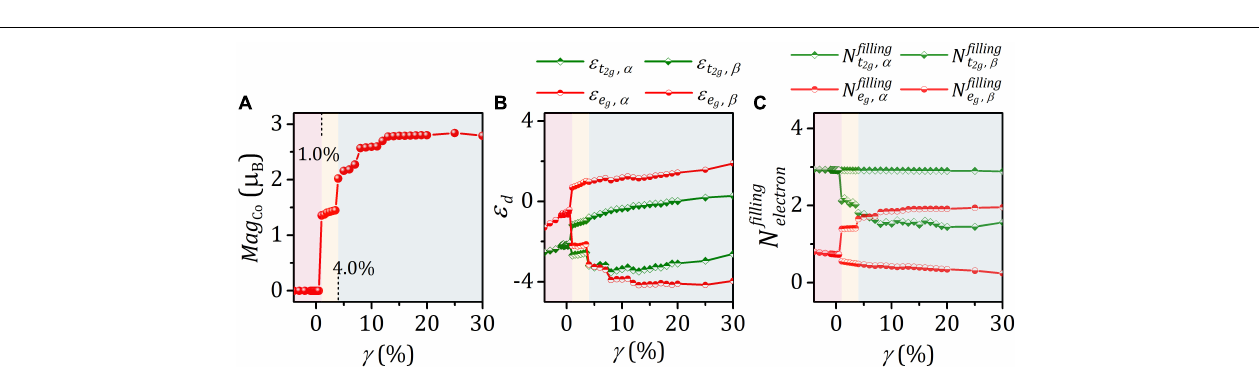
FIGURE 3 | (A–C) Magnetic moment localized at Co atom (Mag Co ), d -band center ( ε d ), and d -band filling ( N filling electron ) versus strain γ .